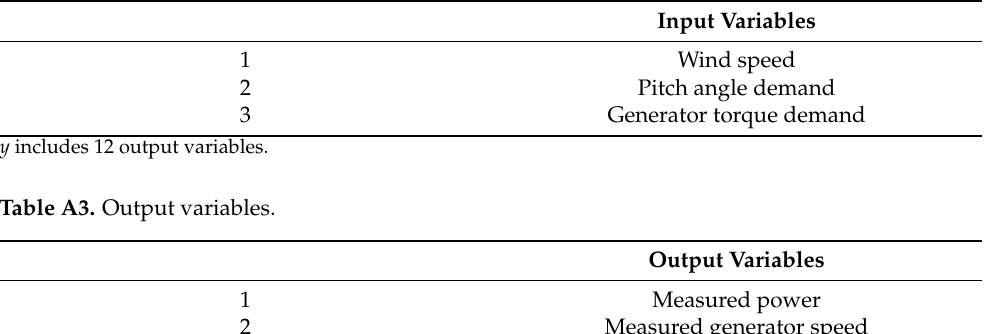
Table A2. Input variables.